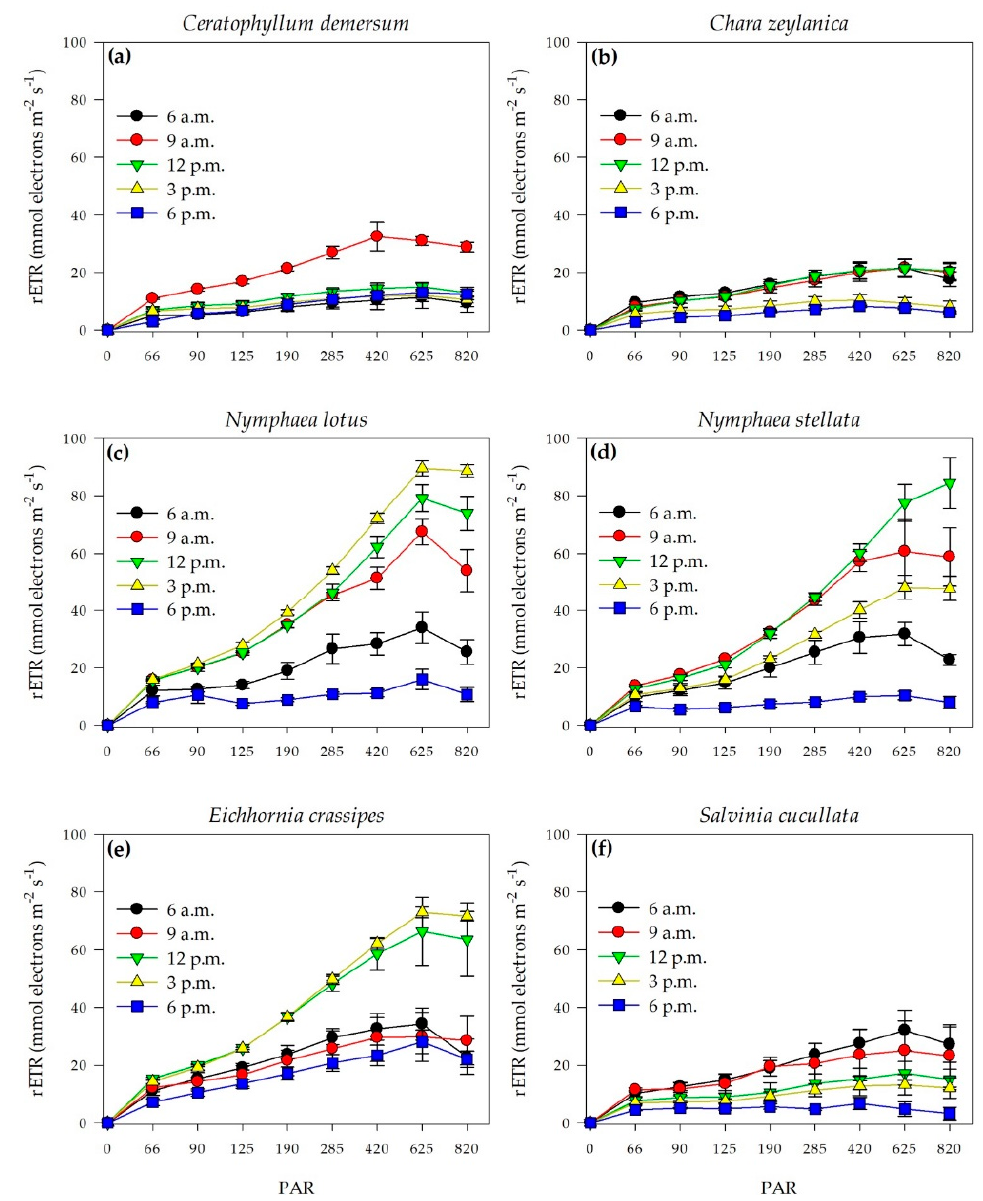
Figure 3. RLCs of six macrophyte species at Thale Noi, Songkhla Lake, from 6 a.m. to 6 p.m. for Ceratophyllum demersum ( a ), Chara zeylanica ( b ), Nymphaea lotus ( c ), Nymphaea stellata ( d ), Eichhornia crassipes ( e ), and Salvinia cucullata ( f ) ( n = 4). Data represent mean ±